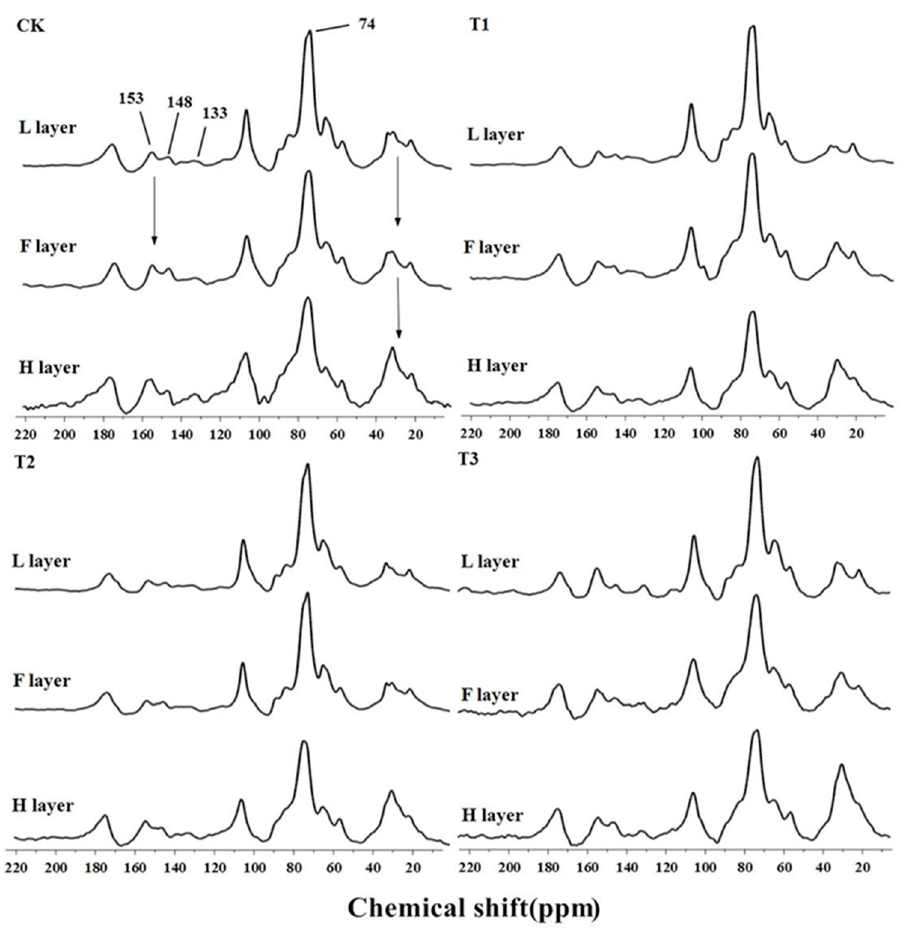
Figure 3. The 13 C cross-polarization magic-angle-spinning (CPMAS) NMR spectra of litter residues at di ff erent layers (L, litter layer; F, fermentation layer; and H, humified layer) as decomposition proceeded. Examples are shown for CK = control treatment, T1 = pH 4.0 treatment, T2 = pH 3.5 treatment, and T3 = pH 3.0 treatments. Superscripts indicate the peaks’ chemical shift. Table 3. E ff ects of simulated acid rain (SAR) treatment and litter residue decomposition layer on the integrated intensity of major 13 C cross-polarization magic-angle-spinning (CPMAS) NMR spectral regions and the ratio of alkyl C to O - alkyl C (A / O -A ratio). E Alkyl C O -alkyl C Aromatic C Carbonyl C A/O-A Ratio Layer L 19.90 ± 2.48C Treatment CK 22.63 ± 3.35b